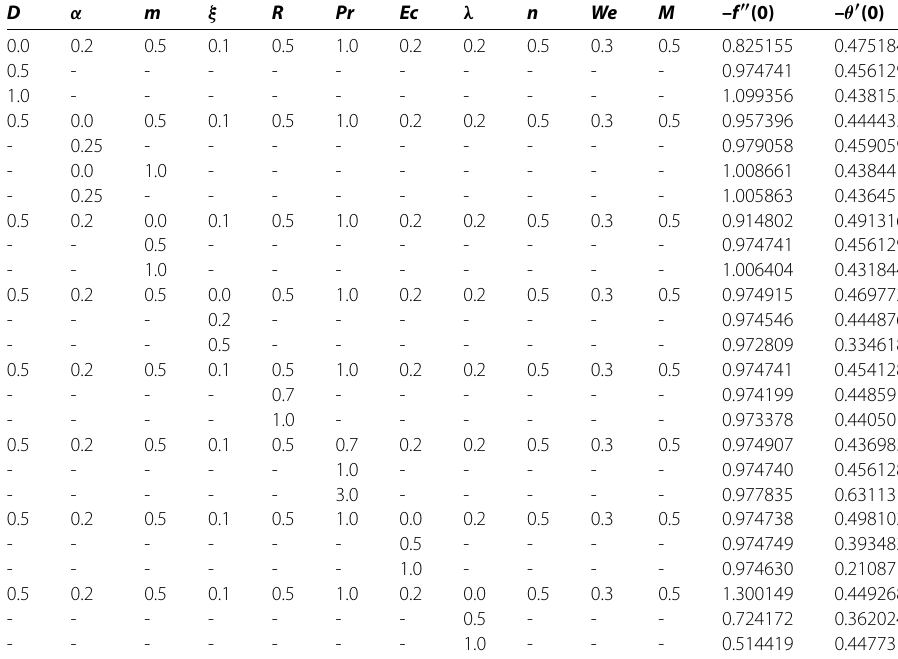
Table 5 Values of – f (cid:2)(cid:2) (0) and – θ (cid:2) (0) for various values of m , D , α , λ , ξ , R , Ec , Pr D α m